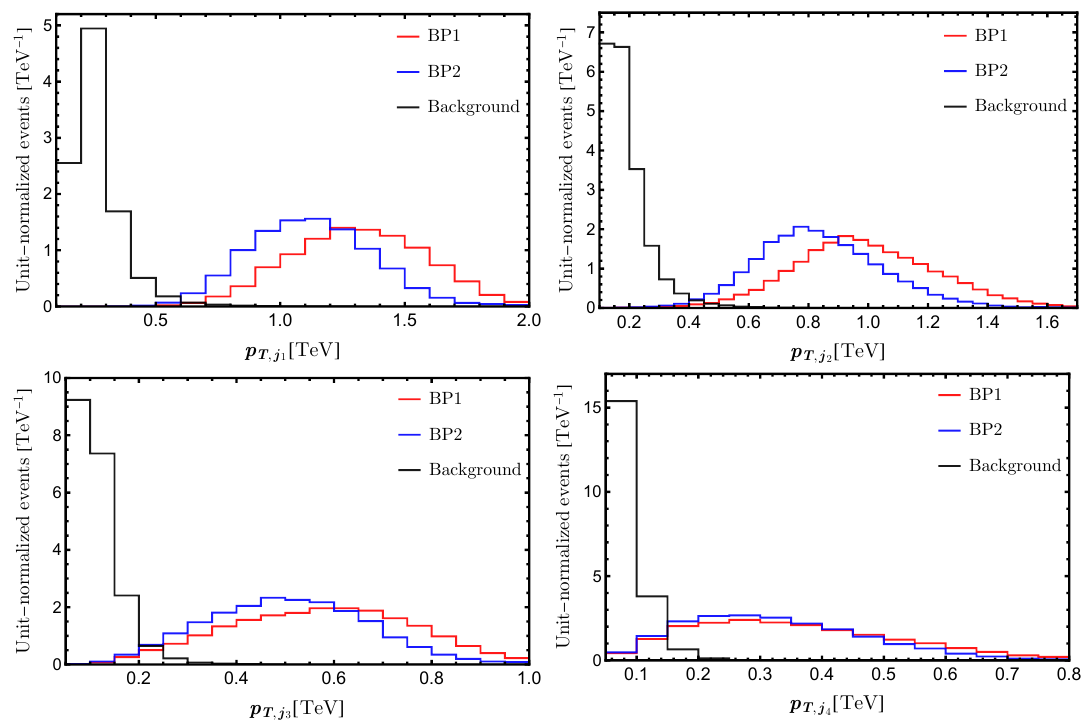
Figure 7 . Distributions of ordered transverse momenta, p T,j I and the QCD 4-jet background